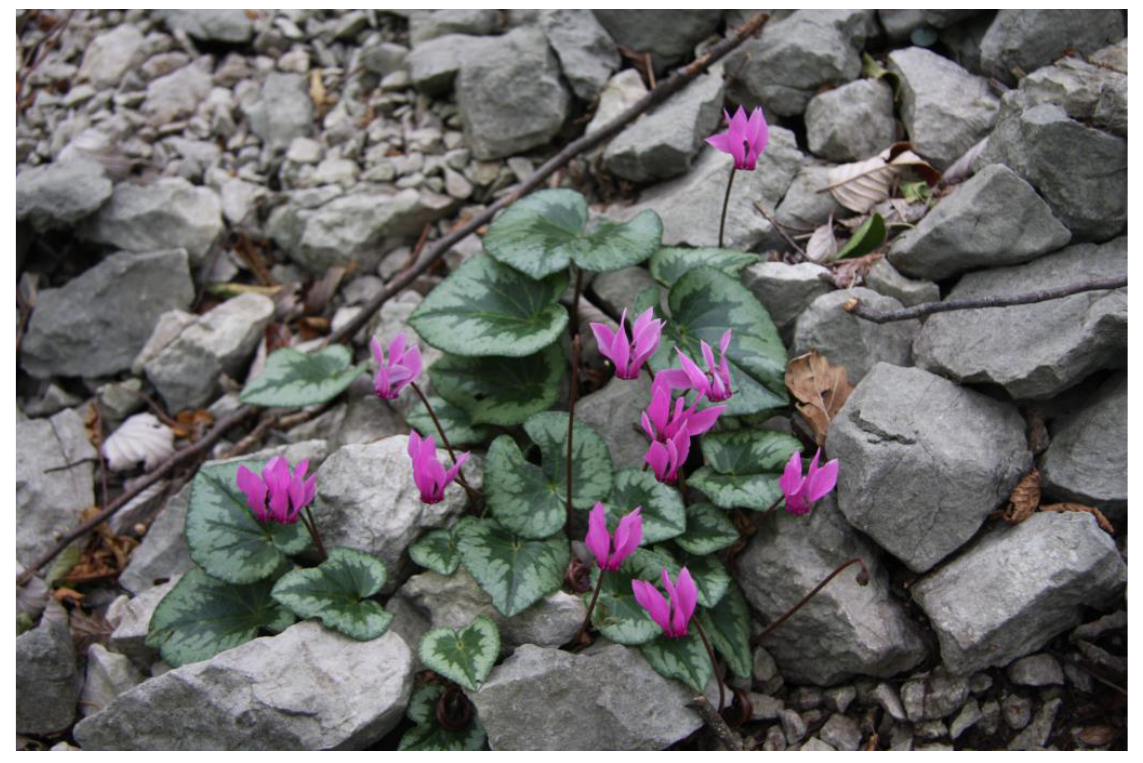
Figure 11. C. purpurascens ‘Nova Gorica’.